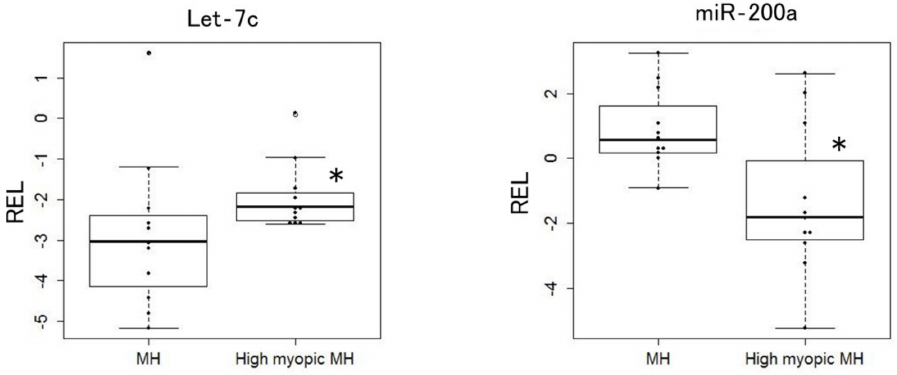
Figure 1. Differentially expressed miRNA in the vitreous of MH eyes and high myopic MH eyes. Box plots of vitreous levels of up-regulated miRNA (let-7c) in high myopic eyes, whereas down- regulated miRNA (miR-200a) in high myopia. The lines inside the boxes denote the median. * p < 0.05, Wilcoxon rank sum test was used for comparison between 2 groups. The amount of target miRNAs was normalized relative to the amount of (median Ct + U6)/2 and the data was presented as relative expression levels (RELs): ∆ Ct = Ct [(median Ct + U6)/2] − Ct [target miRNA]. MH: macular